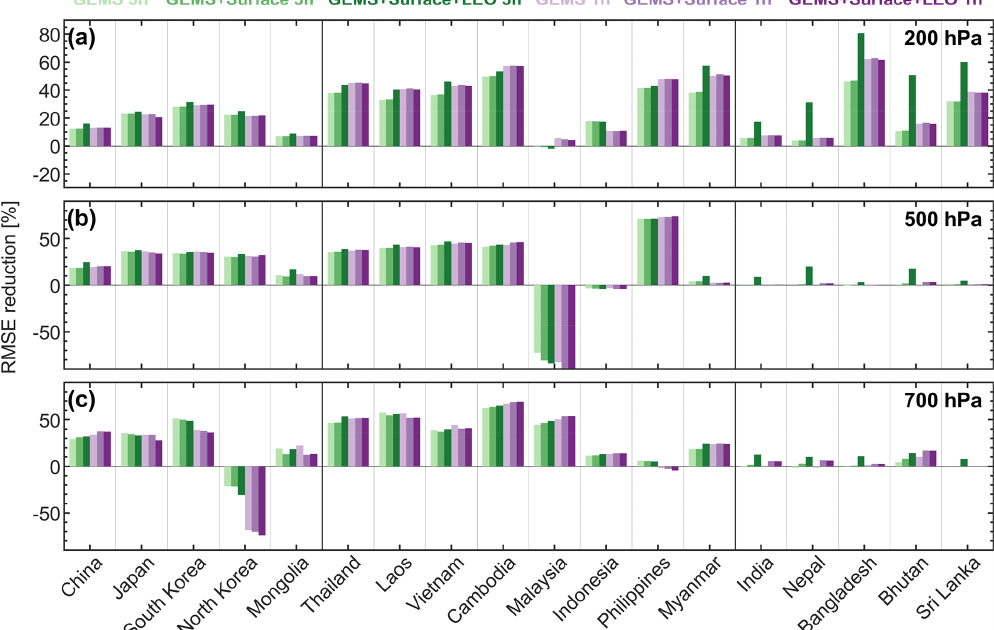
Figure 9. The RMSE reduction in simulated ozone at 200 (a) , 500 (b) , and 700hPa (c) between the assimilation run and the control run relative to the nature run for June 2020 in 18 Asian